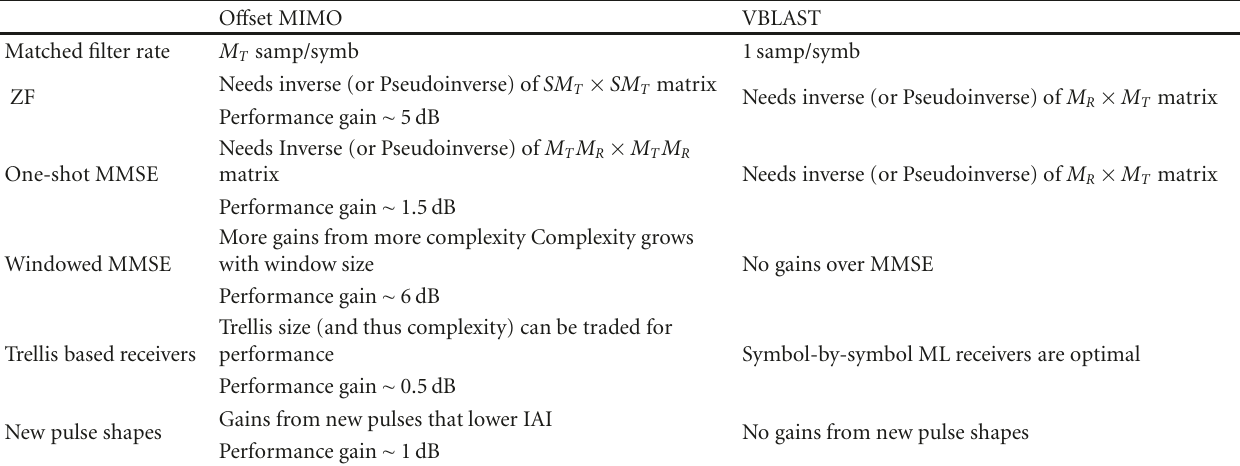
Table 3: Timing aligned MIMO compared to timing o ff set MIMO.